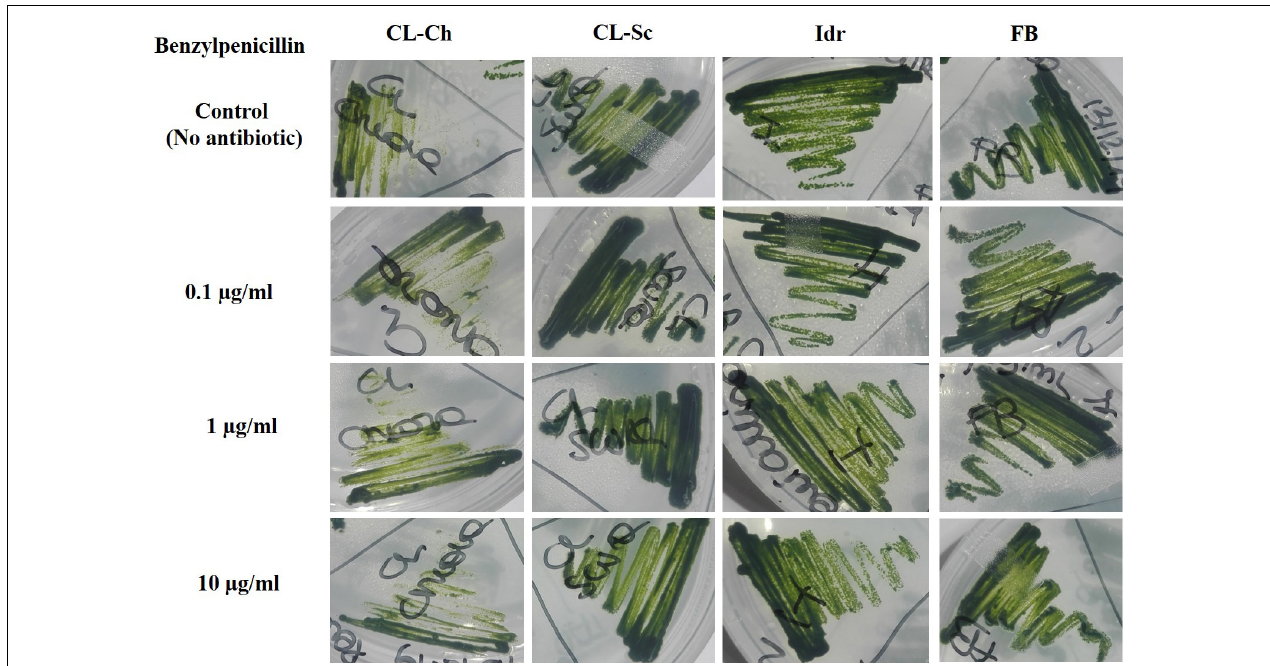
FIGURE 9 | Microalgal growth in presence of different concentrations of Benzylpenicillin (antibiotic substance) in solid agar medium after 7 days